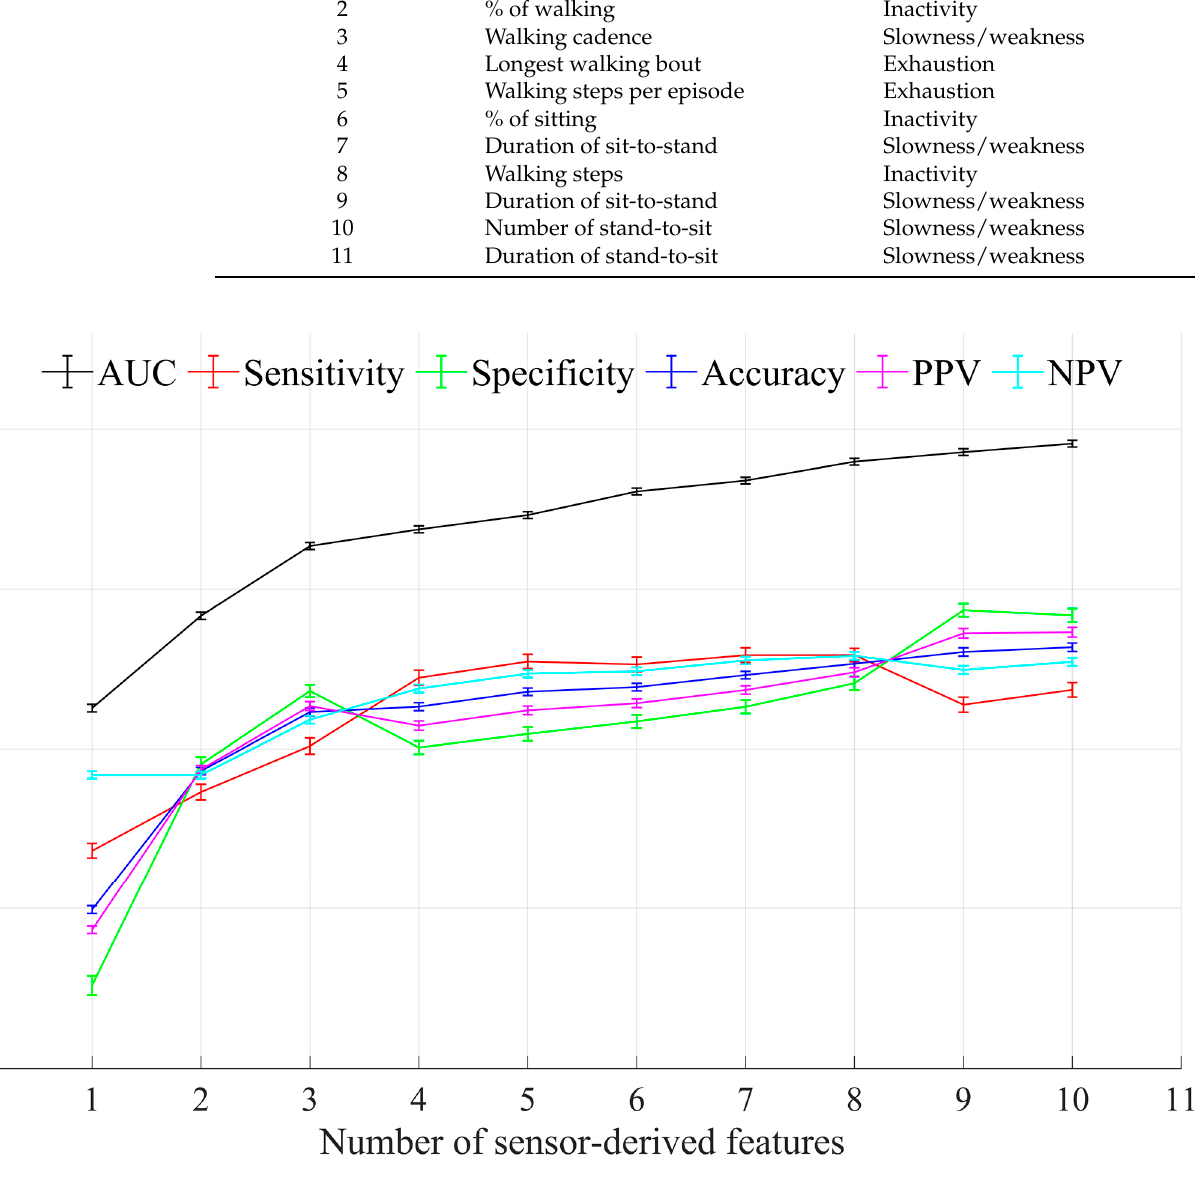
Figure 2. Results of optimal feature selection using machine learning. Error bars indicate 95% confidence intervals. AUC, PPV, and NPV indicate area under the receiver operating characteristic curve, positive predictive value, and negative predictive value, respectively. Table 6 reports the model validations computed by applying the validation datasets to the logistic regression model with the optimal features. Table 6. Model validation.